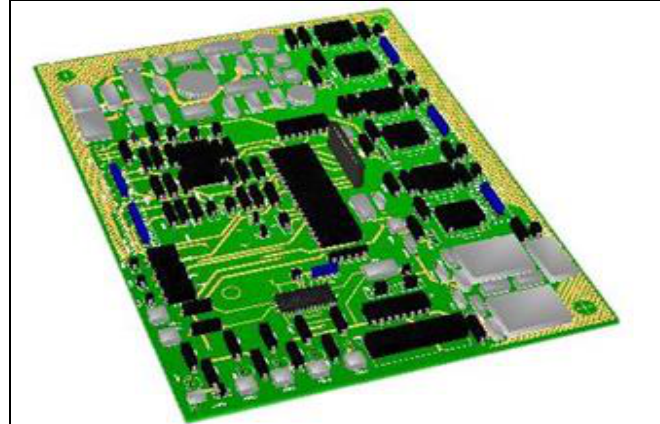
Figura 11: PCB Vista superior 3D, del regulador en Protel . Fuente: Los Autores,